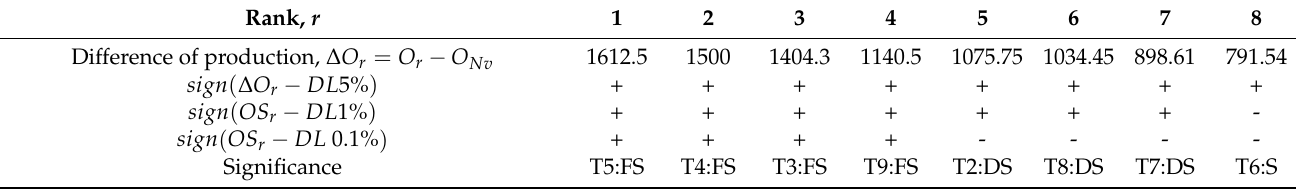
Table 13. Centralization of the data necessary for the classification of variants by the DL test. Rank,